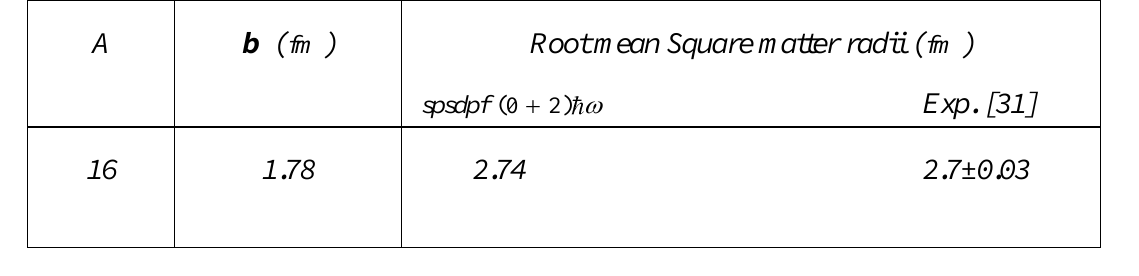
Table 1: The calculated root mean square matter radii of 16 C compared with the experimental